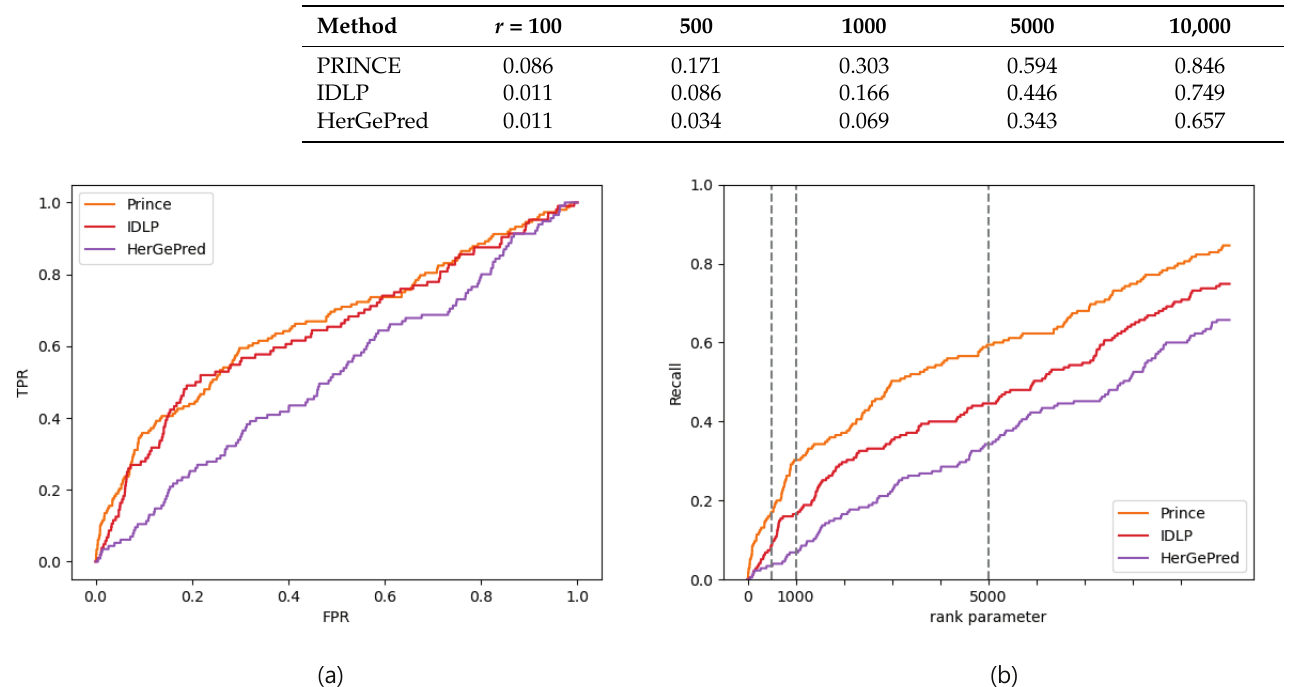
Table 8. Recall values evaluated by gene ranks for disease-gene association prediction without known disease genes from sample-2.